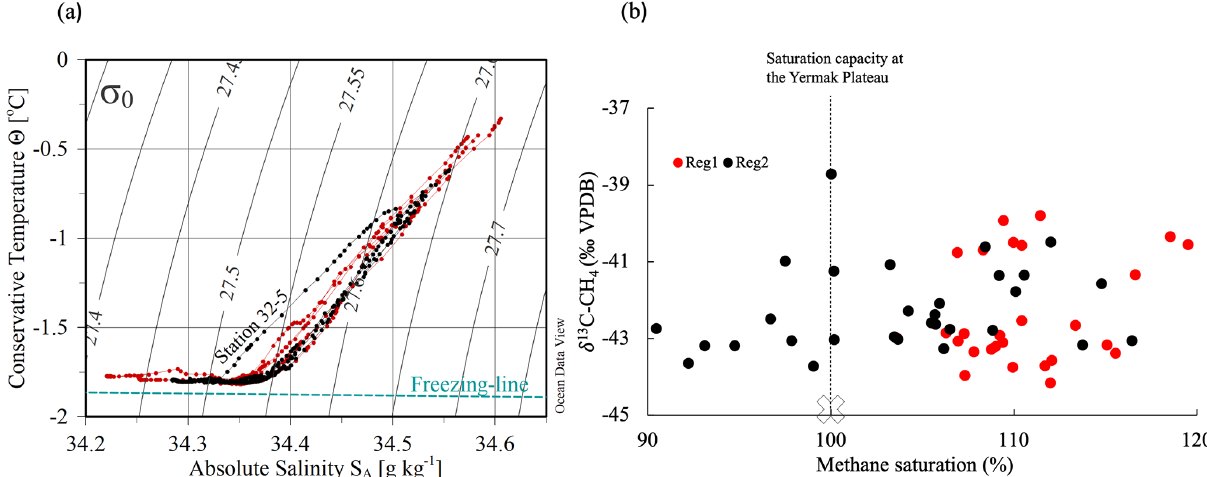
Figure 3. (a) Temperature-salinity (TS) diagram for the upper 100m at the methane sampling stations during the ice drift. In red are the stations located over the Yermak Plateau (Region 1), and in black are those over the Yermak Plateau eastern flanks (Region 2). The dashed line indicates the salinity dependence of the freezing temperature. (b) Methane saturation vs. the δ 13 C signature of methane in seawater. Red and black colors indicate the regions and the dashed line the saturation capacity (100%) at the Yermak Plateau (see Sect. 4.2). The atmospheric background signature of methane of − 45‰VPDB is marked with a